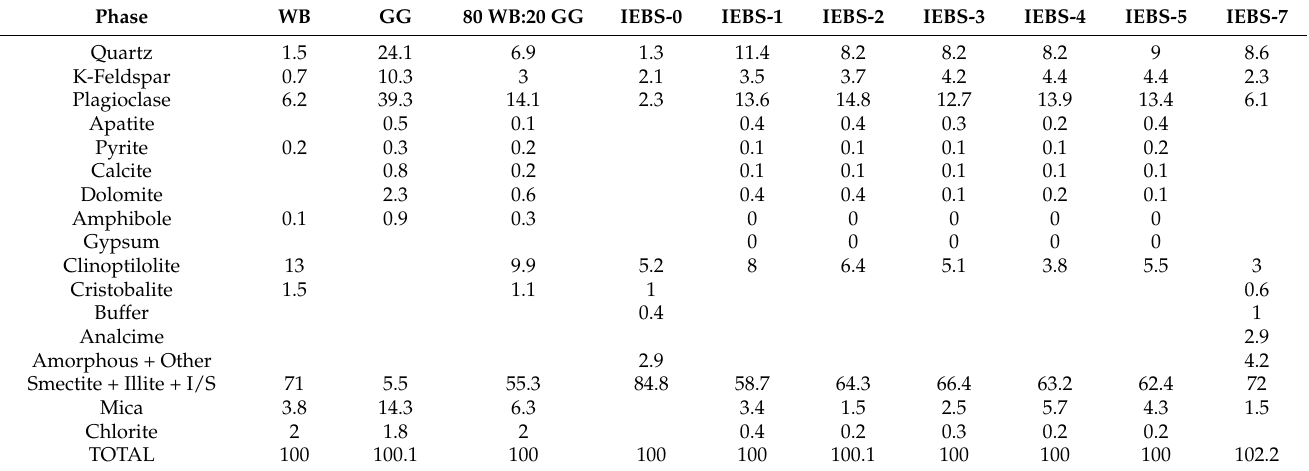
Table 3. QXRD values of minerals found in analyses of reactants before and after the experiments (see Methods, Section 2.2 for details). Abbreviations: WB = Wyoming bentonite; GG = Grimsel granodiorite. Mineral abundance errors for each phase are approximately ± 5 wt. % for clay minerals (smectite, illite, mica, chlorite, kaolinite, saponite) and ± 1 wt. % for all other